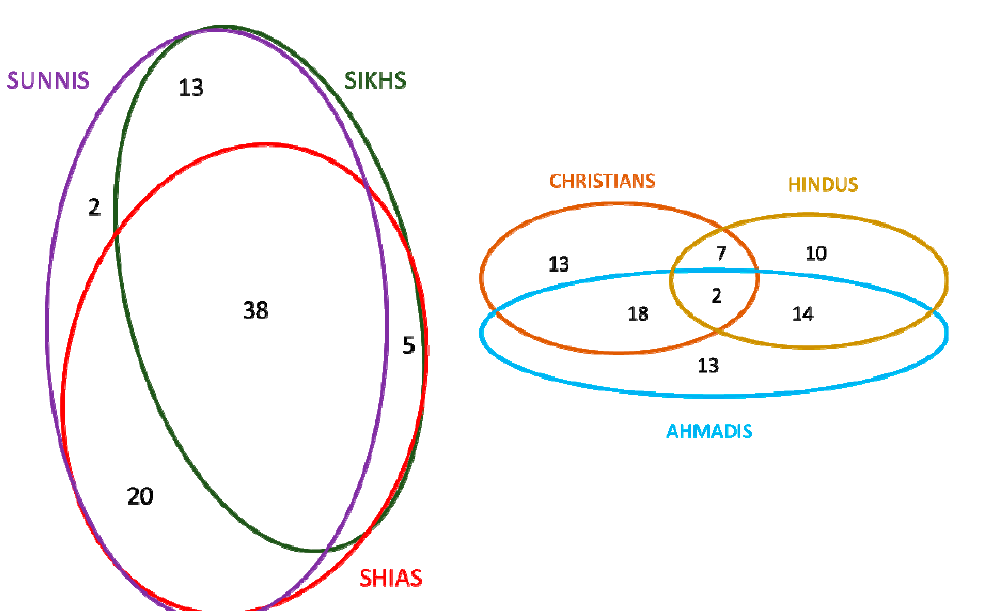
Figure 8. Intuitive best fit Venn diagrams comparing the recorded wild food plants among the six religious groups divided into two clusters.